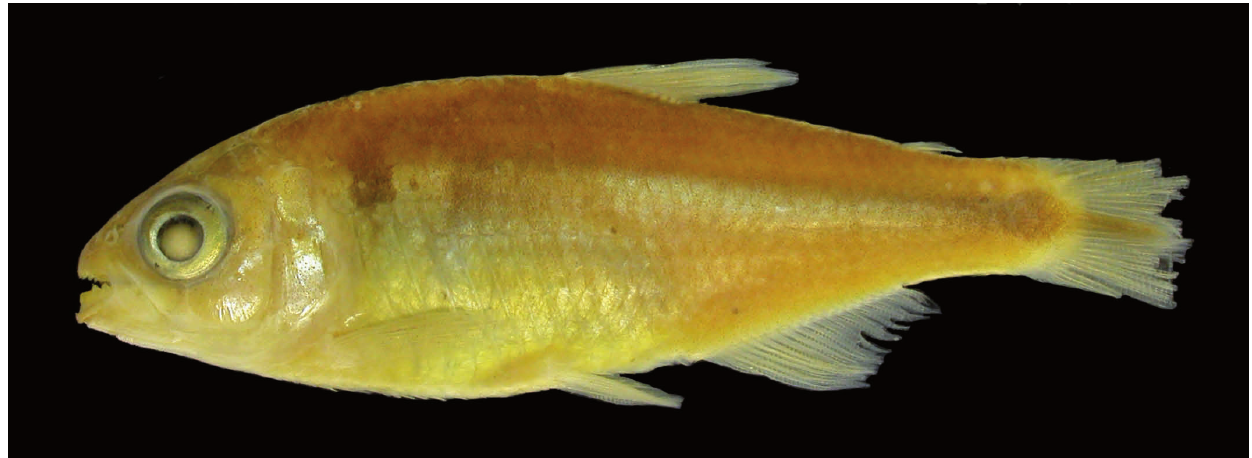
Fig. 1. Astyanax obscurus , ZMB 7478, syntype, 57.8 mm SL, rio Cadeia above of the large waterfalls, Santa Maria do Herval, Rio Grande do Sul, Brazil.